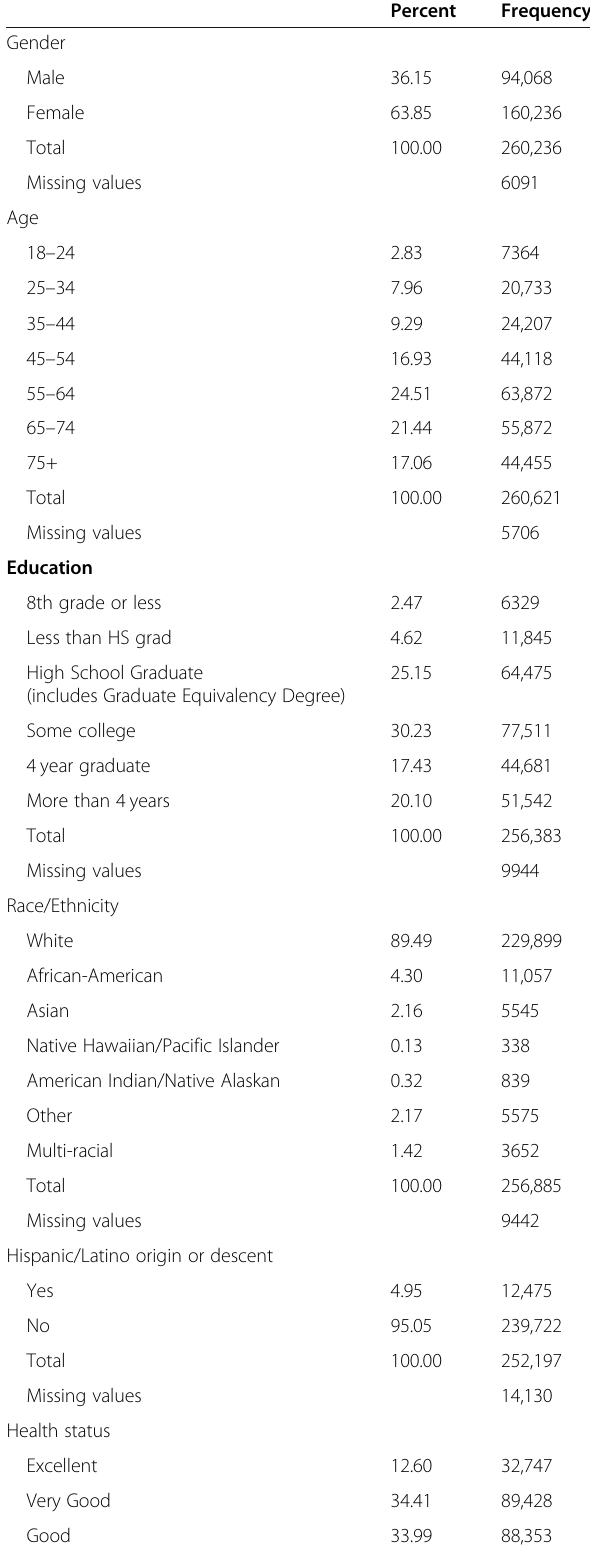
Table 1 Sample demographic information, CAHPS clinician and group adult visit survey 1.0